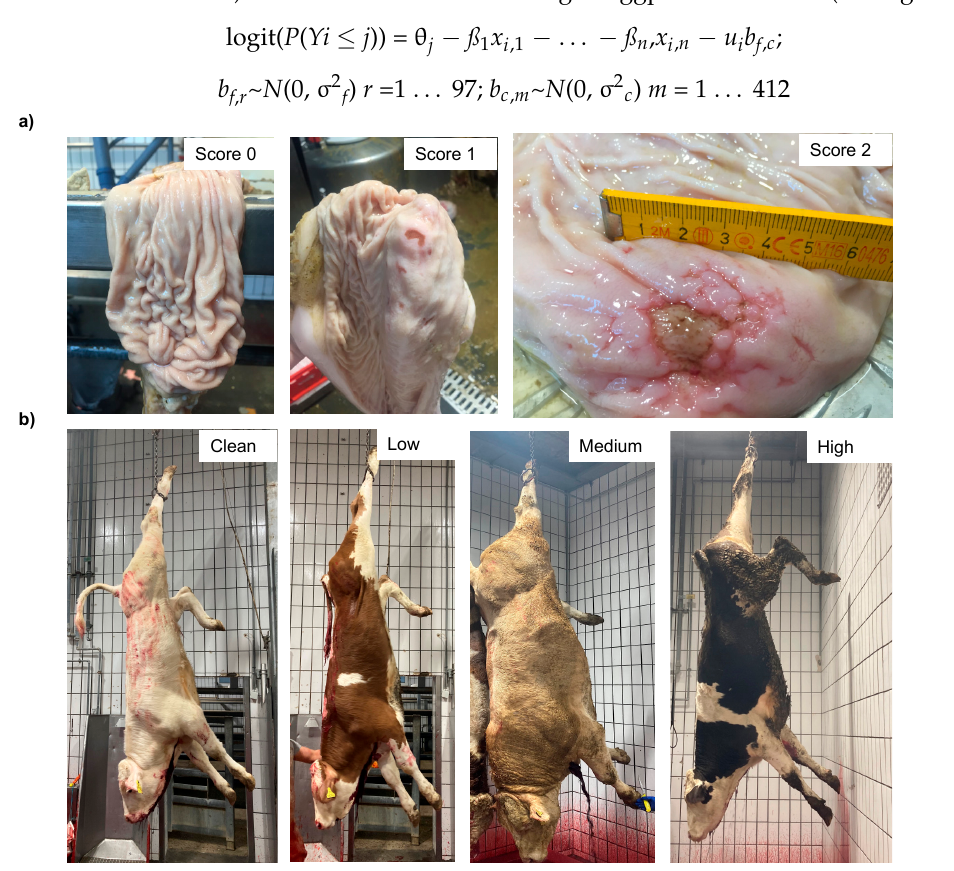
Figure 1. Illustration of the different scales of the dependent variables ( a ) abomasal lesions (i.e., 0 = normal abomasal mucosa (free); 1 = superficial lesions of the abomasal mucosa; 2 = deep lesions of the abomasal mucosa) and ( b ) cleanliness level (i.e., clean; low contamination; medium contamination; high contamination). Pictures were taken by the first author during the study.